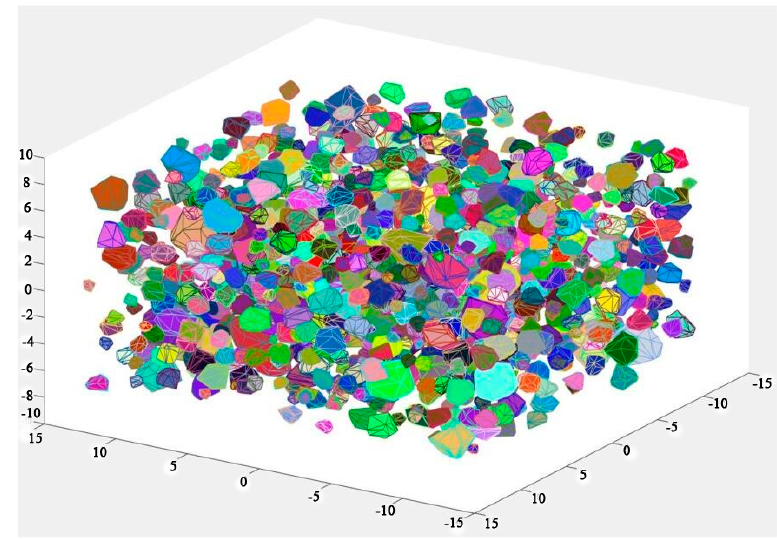
Figure 3. Separated aggregates in a certain space by shrinking process.